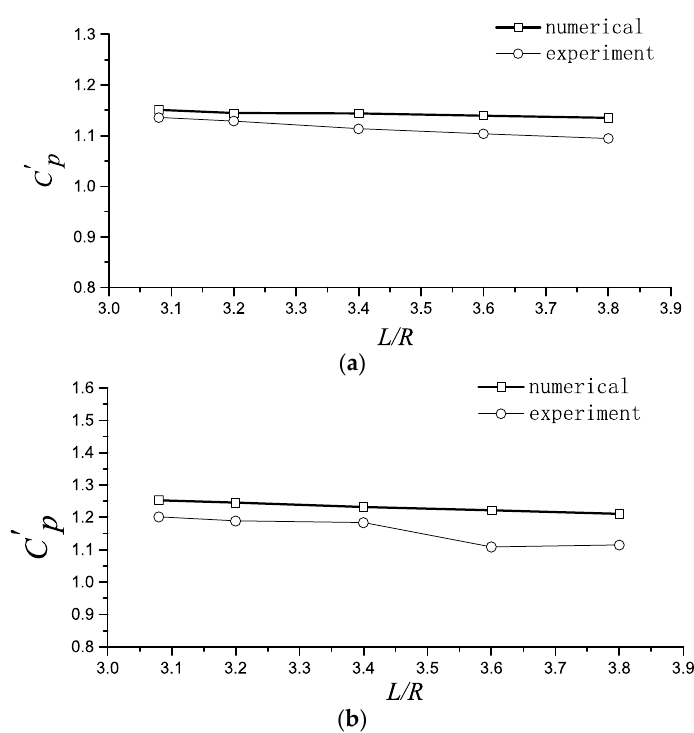
Figure 4. The variation of relative power coefficient with turbine spacing of double turbines in parallel connection. ( a ) λ = 1.7; ( b ) λ = 2.75.